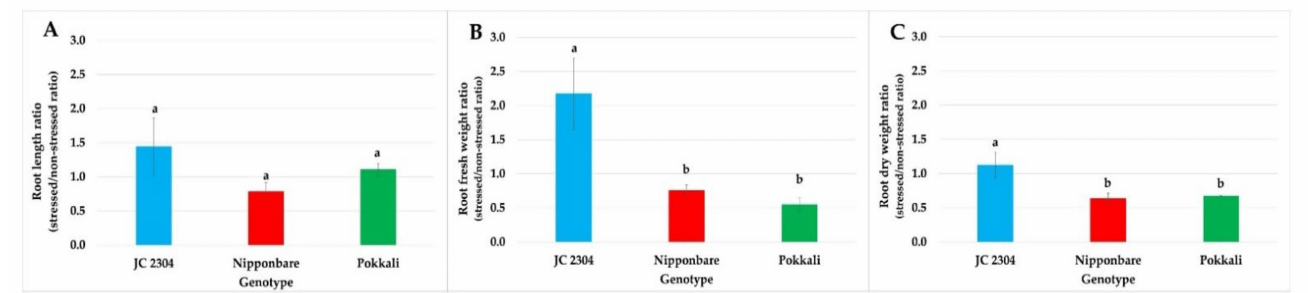
Figure 4. Effects of salinity stress (150 mM NaCl) on root length and root biomass (14 DAT) of wild and cultivated rice at the seedling stage. ( A ) Relative root length. ( B ) Relative root fresh weight. ( C ) Relative root dry weight. Data represent the means ± SE ( n = 4). Value labeled with different letters is significantly different at p < 0.05, based on the Turkey HSD test.